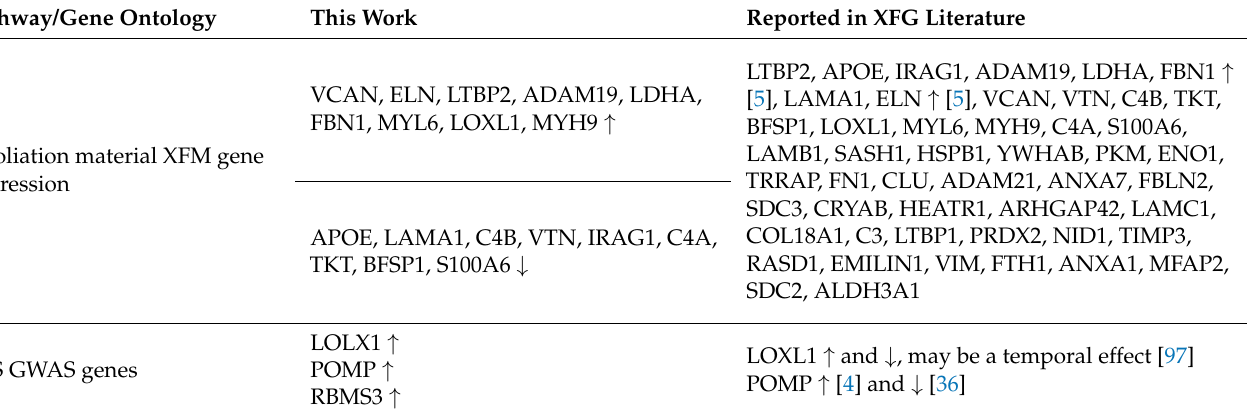
Table 4. Comparison of pathways and biological processes with literature. This table compares pathways and gene ontologies reported to be relevant in the pathophysiology of XFG and those found in this work. ↑ indicates upregulation, ↓ downregulation, == no change, ? unknown. Important alias gene symbols have been mentioned between